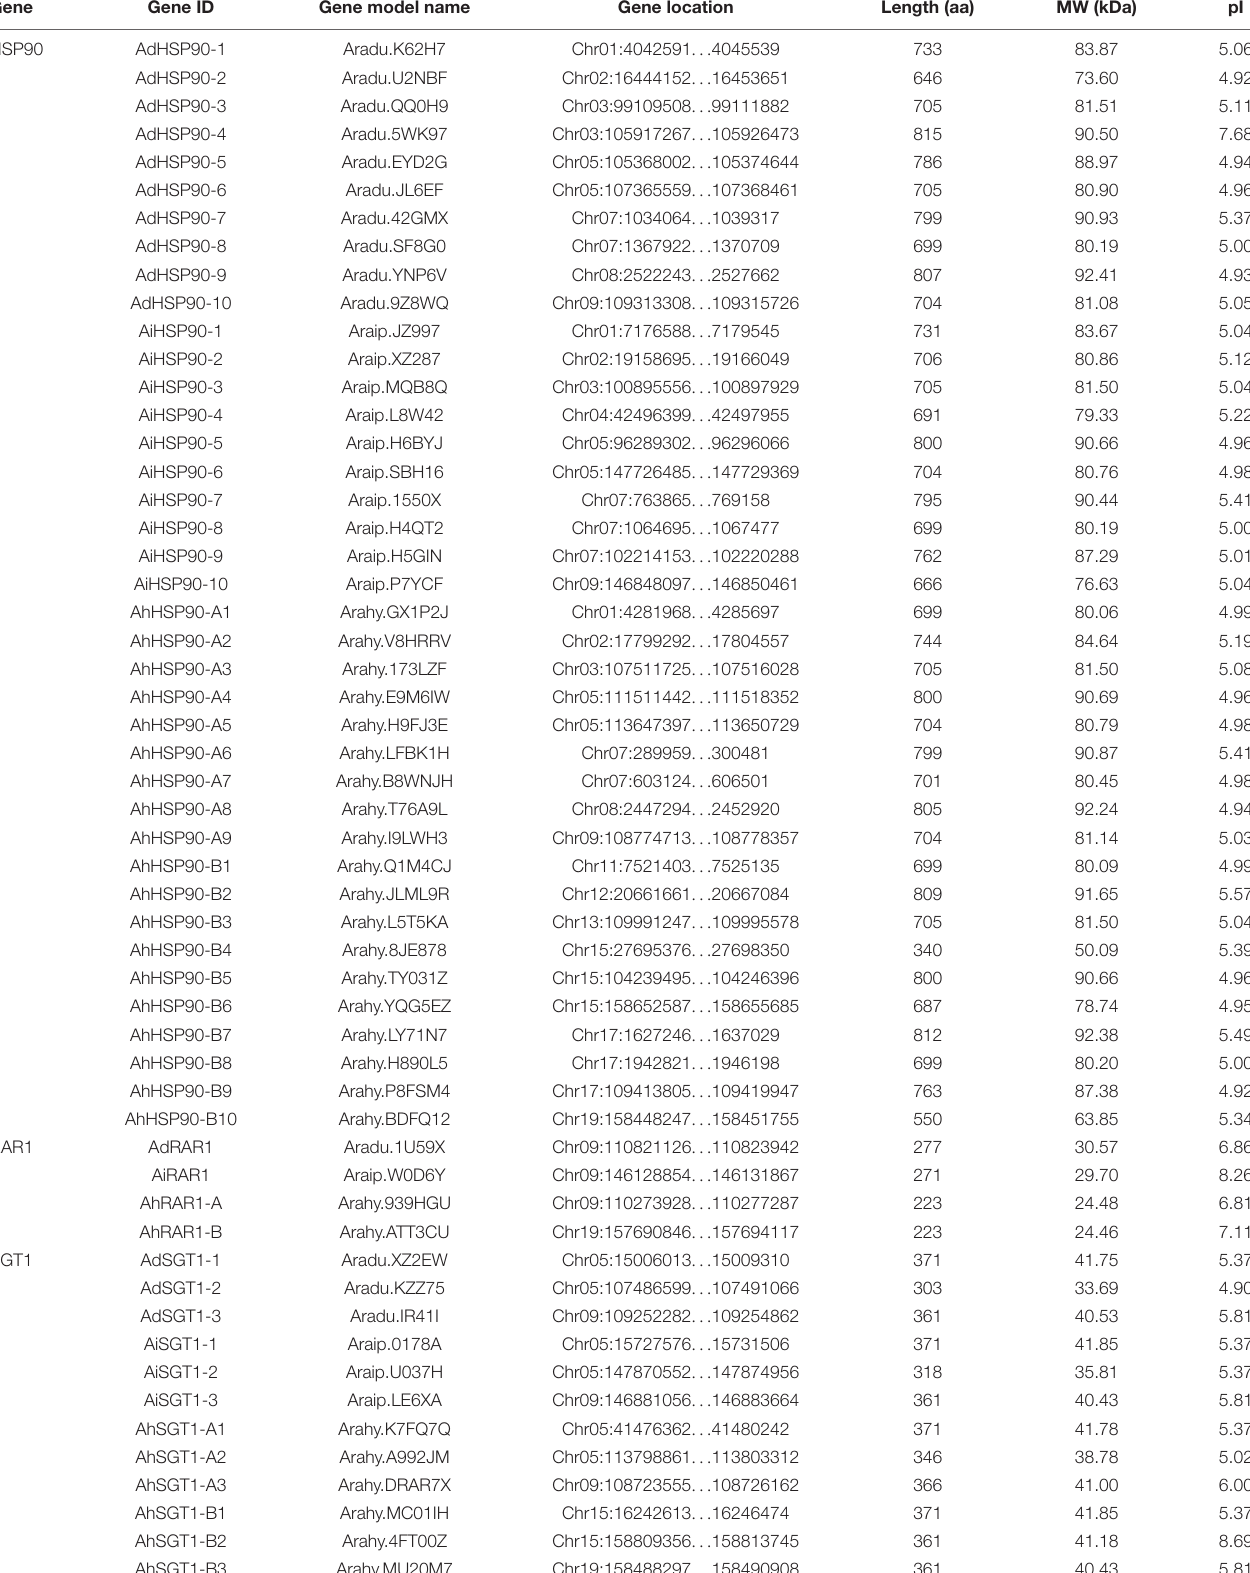
TABLE 1 | The HRS-related genes in Arachis